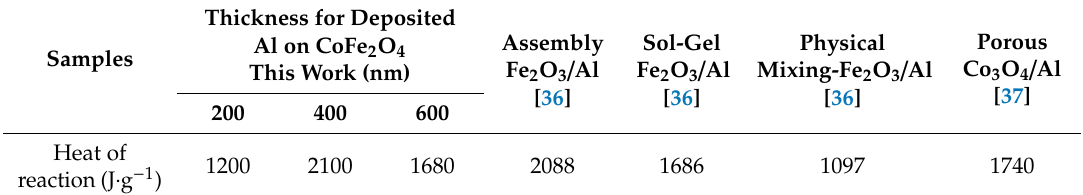
Figure 5. The di ff erential scanning calorimetry (DSC) curve of the CoFe 2 O 4 / Al NWs nanothermite film Figure 5. The differential scanning calorimetry (DSC) curve of the CoFe 2 O 4 /Al NWs nanothermite film (Al = 400 nm). (Al = 400 nm). Table 1. Comparisons of exothermic performances of the CoFe 2 O 4 / Al, Fe 2 O 3 / Al and Co 3 O 4 / Al. Table 1. Comparisons of exothermic performances of the CoFe 2 O 4 /Al, Fe 2 O 3 /Al and Co 3 O 4 /Al.